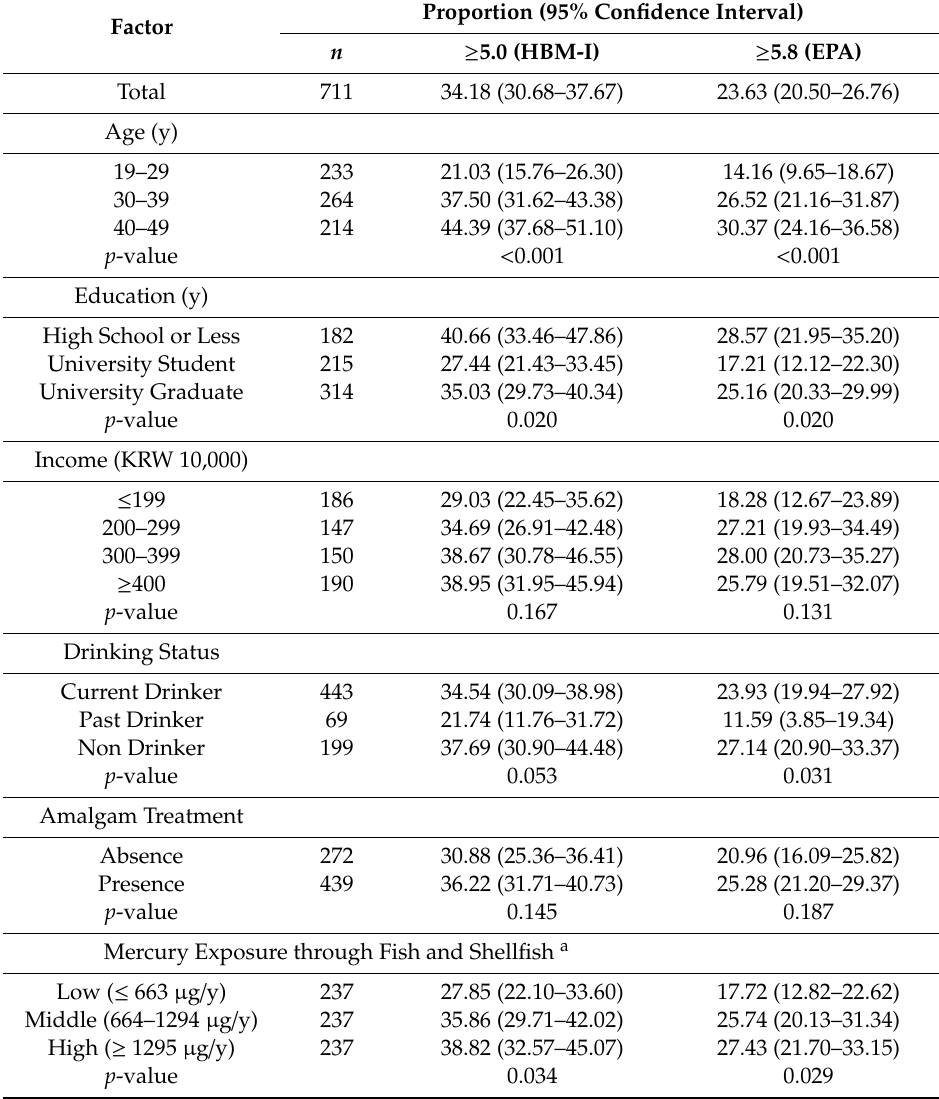
Table 3. Proportions of total blood mercury concentrations exceeding the standard